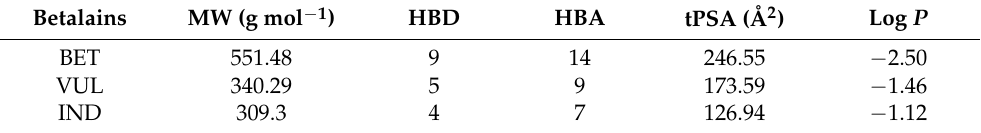
Table 1. Physicochemical properties of selected betalains. Parameters include molecular weight (MW), number of hydrogen bond donors (HBD) and hydrogen bond acceptors (HBA), topological polar surface area (tPSA) and octanol/water partition coefficient (Log P ). Data were acquired from ChemDraw